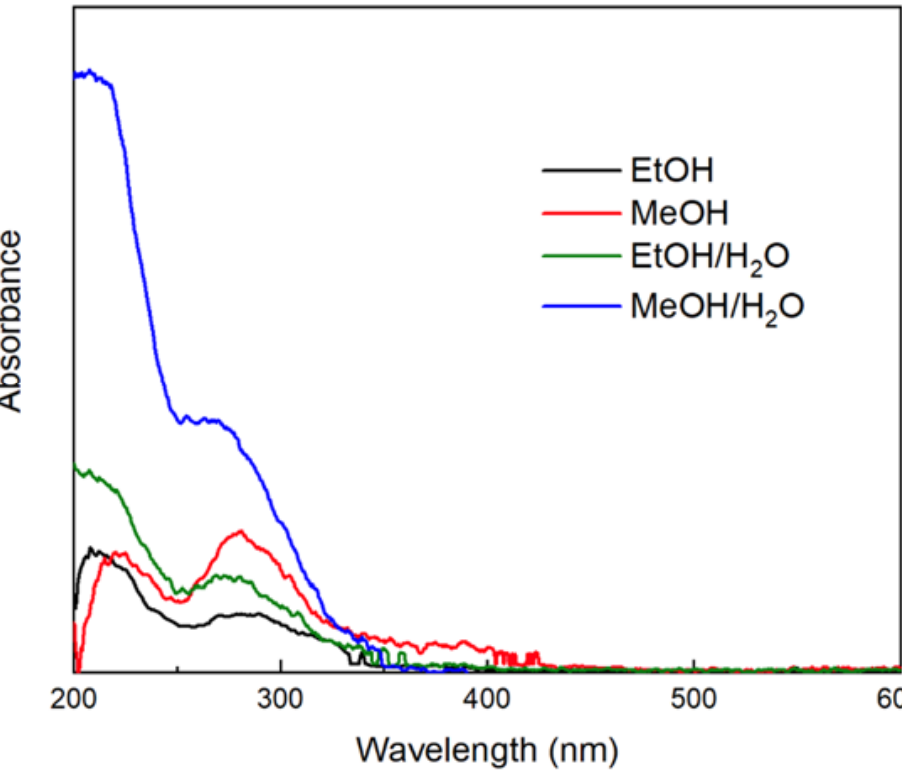
Figure 1. Plant extract absorbance spectra from different types and mixtures of solvents.